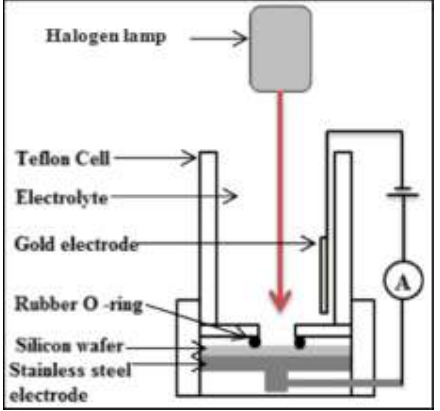
Figure 1: PS photoelectrochemical etching technique schematic diagram.